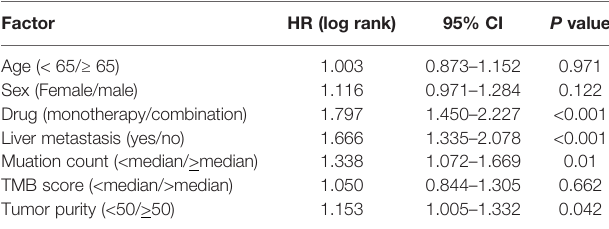
TABLE 2 | Multivariate analyses of clinical parameters on OS.